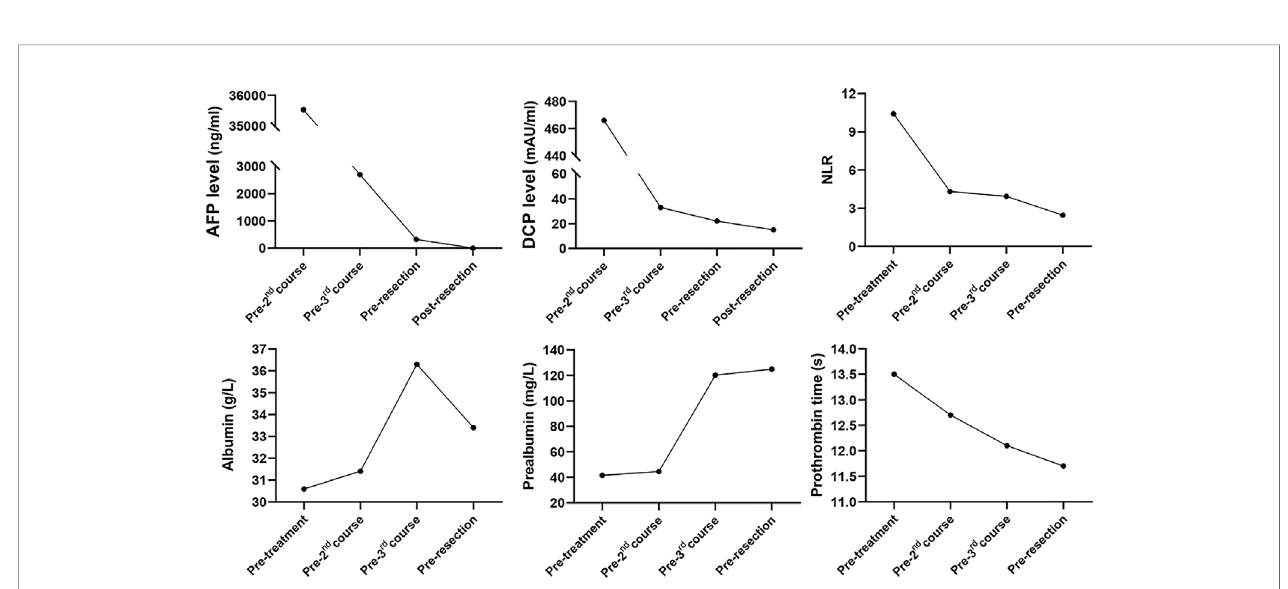
FIGURE 2 | Dynamic changes in tumor marker levels, systemic in fl ammation index and liver function during treatment process. AFP, alpha-fetoprotein; DCP, des- g - carboxy prothrombin; NLR, neutrophil-lymphocyte